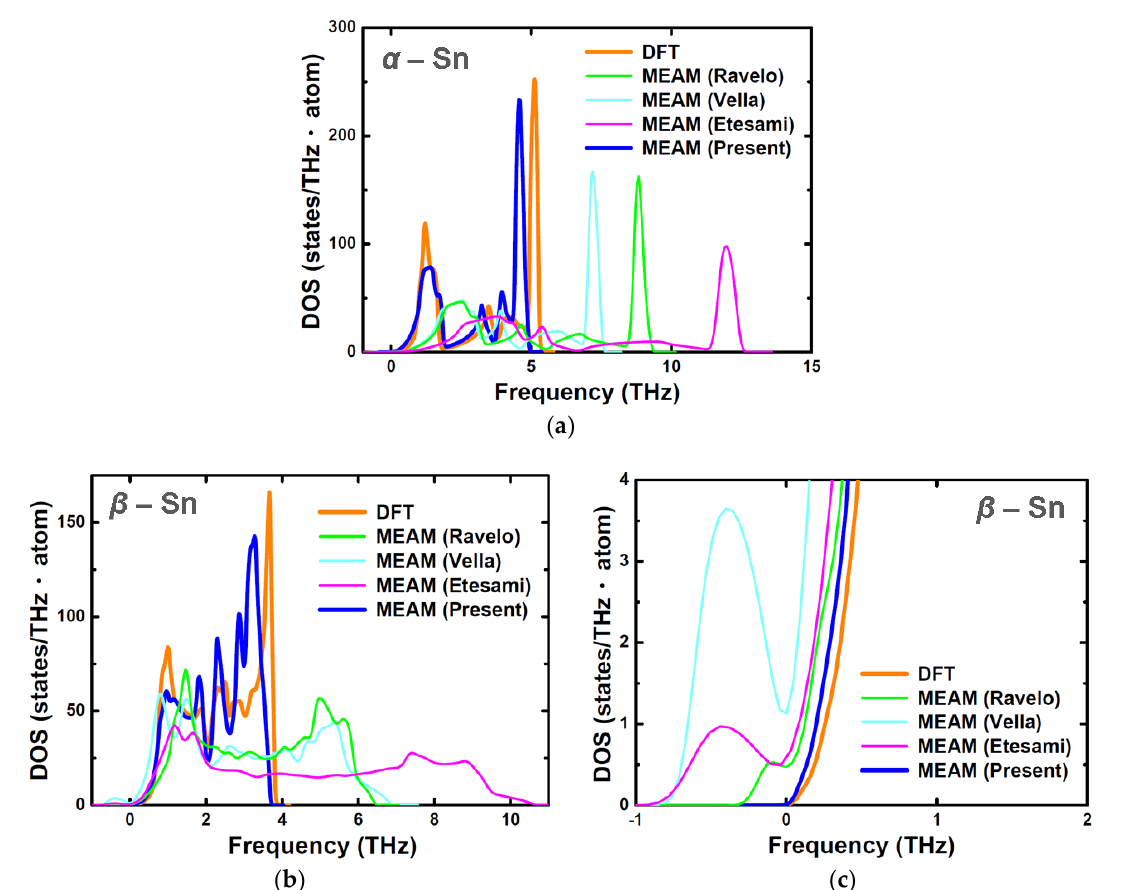
Figure 4. Phonon density of states (DOS) of ( a ) α phase and ( b ) β phase, calculated based on the harmonic approximation (HA). The results using the present 2NN MEAM potential are compared with the present DFT results and the results using previous MEAM potentials by Ravelo and Baskes [5], Vella et al. [12], and Etesami et al. [13]. ( c ) A magnified figure of Figure ( b ) is presented to clarify the existence of imaginary phonon modes.